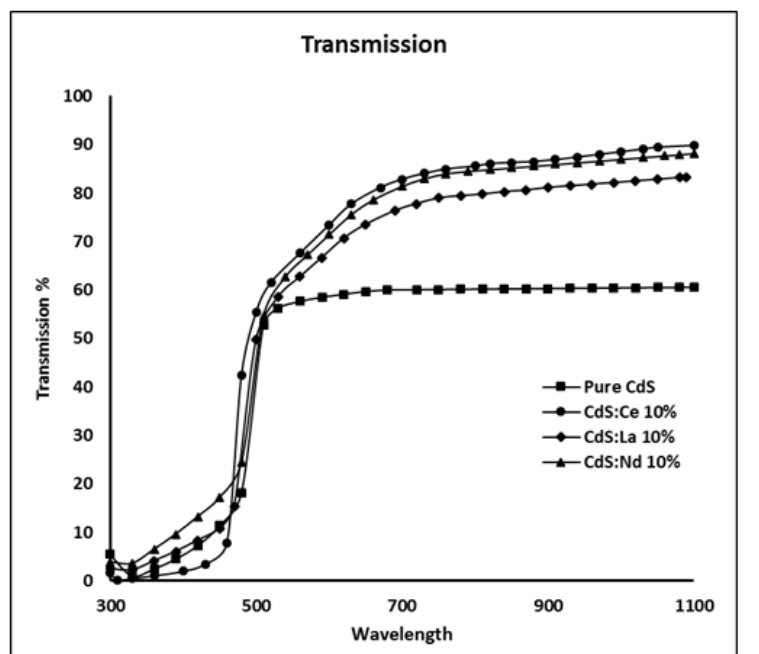
Fig.3: Transmission for pure CdS and (Ce, La and Nd) doped CdS at 10